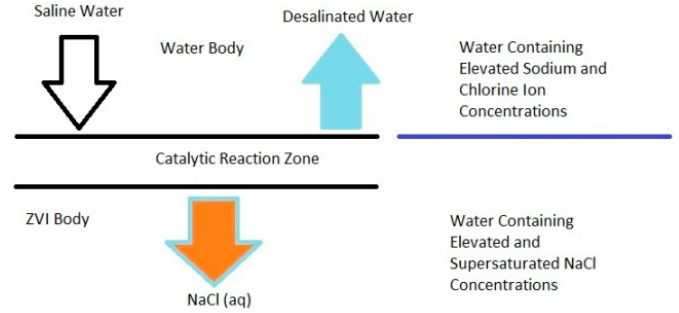
Figure 15. Catalytic NaCl sequestration model. Source: [17].